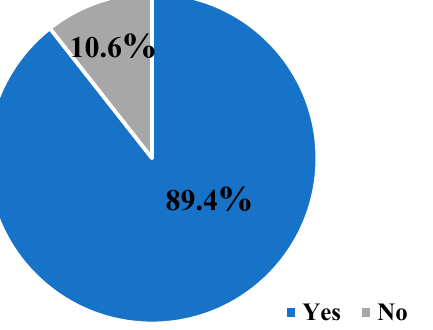
Figure 5. WTP for swampy wetland’s sustainable use and conservation.